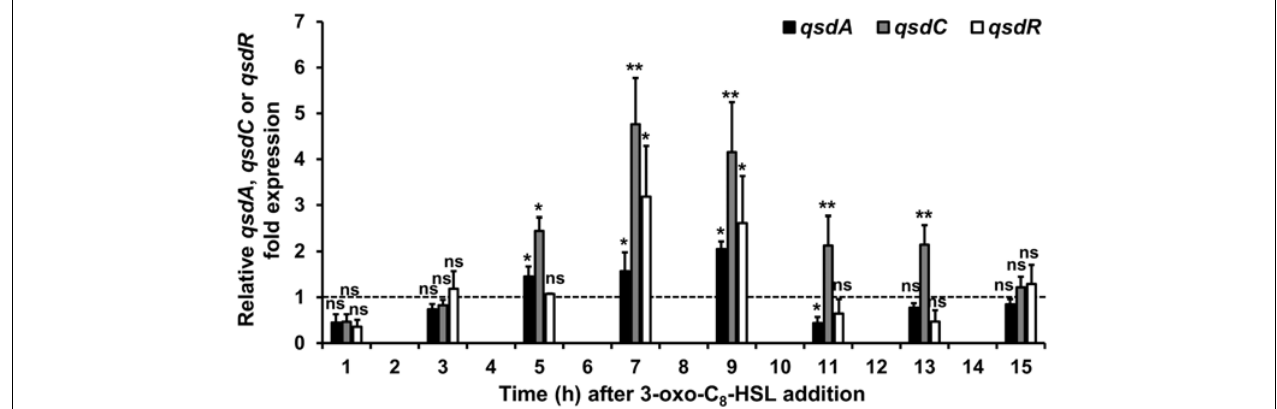
FIGURE 2 | Induction of the qsd operon expression by 3-oxo-C 8 -HSL. qRT-PCR analysis of the qsdA , qsdC , and qsdR transcription was conducted in the R. erythropolis R138 wild-type strain grown in 7H9 medium in which 3-oxo-C 8 -HSL was added at mid-exponential phase. Expression levels of qsdA , qsdC , and qsdR are relative to those obtained in the same medium without the inducer. The dotted line indicates the same mRNA expression between the induced condition and without the inducers. Data shown are mean values obtained from three independent experiments. Statistical analysis was performed by the DataAssist TM software (v3.01) used for calculating relative quantitation of gene expression, based on the comparative C T (2 − (cid:49)(cid:49) CT ) method. ∗ p -value < 0.05; ∗∗ p -value < 0.01; ns means no significant difference.